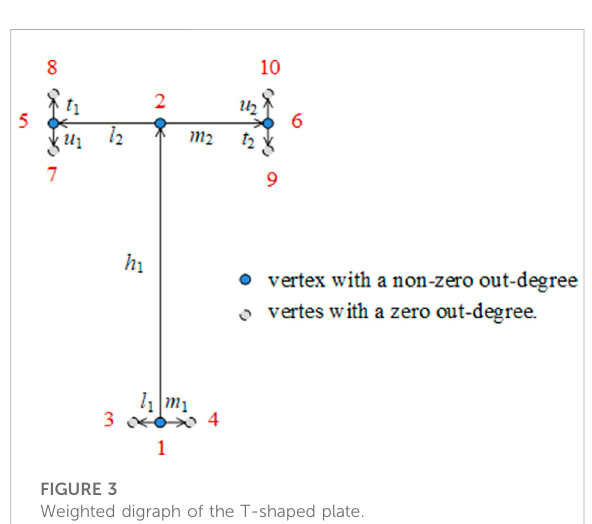
FIGURE 3 Weighted digraph of the T-shaped